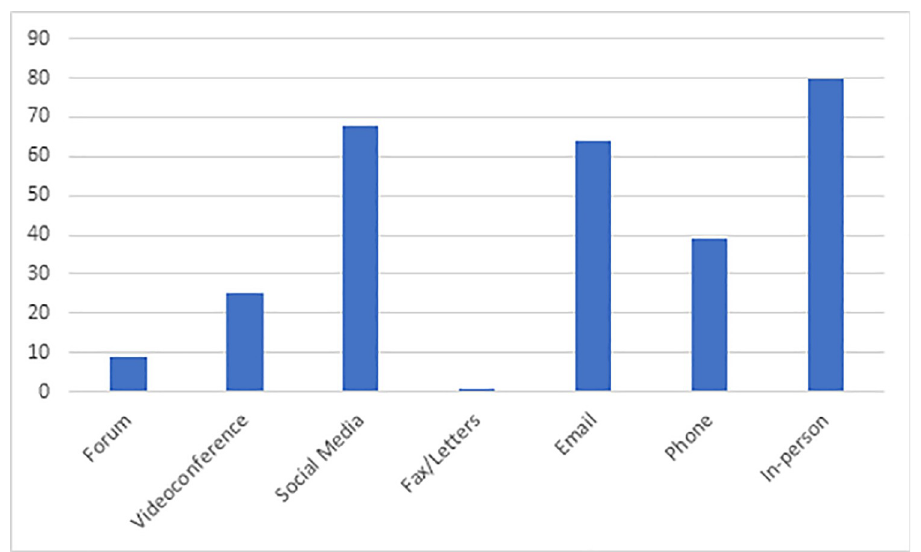
Fig 1. Preferred communication tools among dental